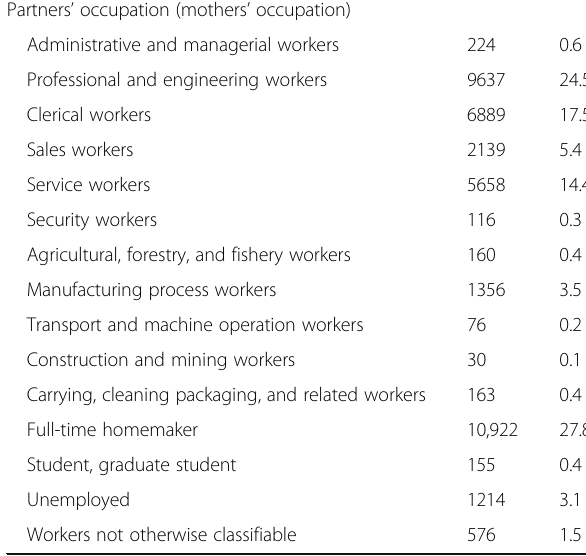
Table 1 Characteristics of the study participants ( N = 39,315) (Continued) Mean SD Partners ’ occupation (mothers ’